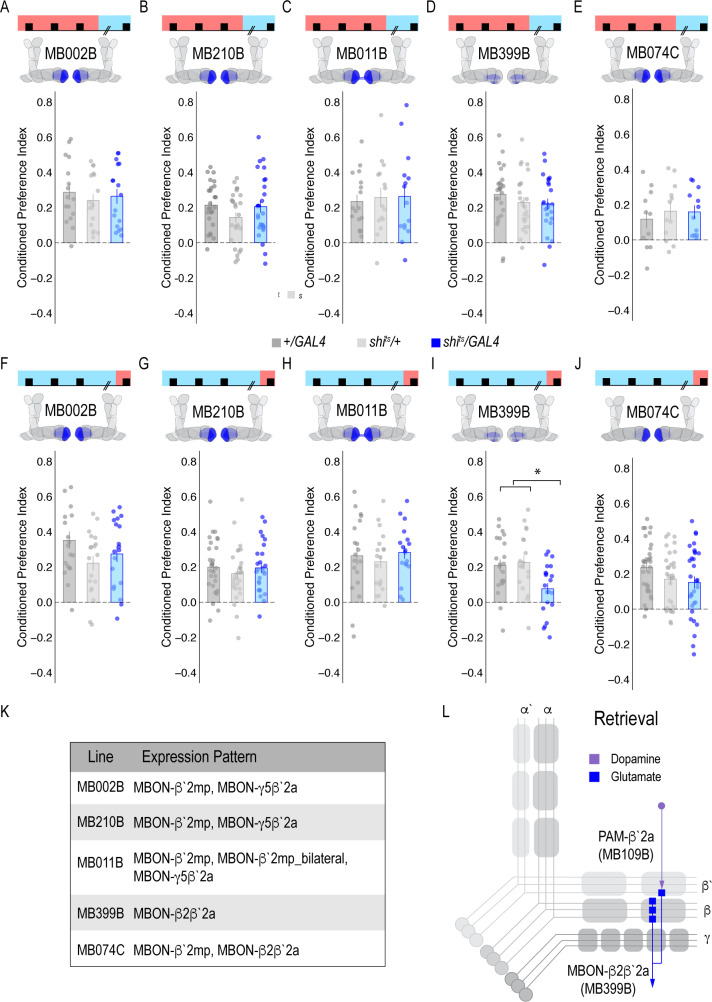
Memory expression during retrieval, but not acquisition, is dependent on a sparse population of glutamatergic MBONs.(A–E) Thermogenetic inactivation of glutamatergic MBONs innervating similar compartments to β`2a PAM DANs during acquisition did not disrupt encoding of alcohol-associated preference. (F–J) However, inactivating neurotransmission during retrieval revealed the specific importance of MBON β2β`2a glutamatergic neuron (I) for the expression of alcohol-associated preference F(2,59)=5.62, p=0.006. One-way ANOVA with Tukey Posthoc was used to compare mean and variance. *p<0.01 Bar graphs illustrate mean +/- standard error of the mean. Raw data are overlaid on bar graphs. Each dot is an n of 1, which equals approximately 60 flies (30 per odor pairing). (K) Chart illustrating the expression pattern of each split-GAL4 tested with intensity ranges of 2–5 (Aso et al., 2014a). (L) Updated model of circuits responsible for expression of alcohol-associated preference. Retrieval circuits require specific subsets of DANs and a single MBON glutamatergic neuron innervating the β2`a compartment.